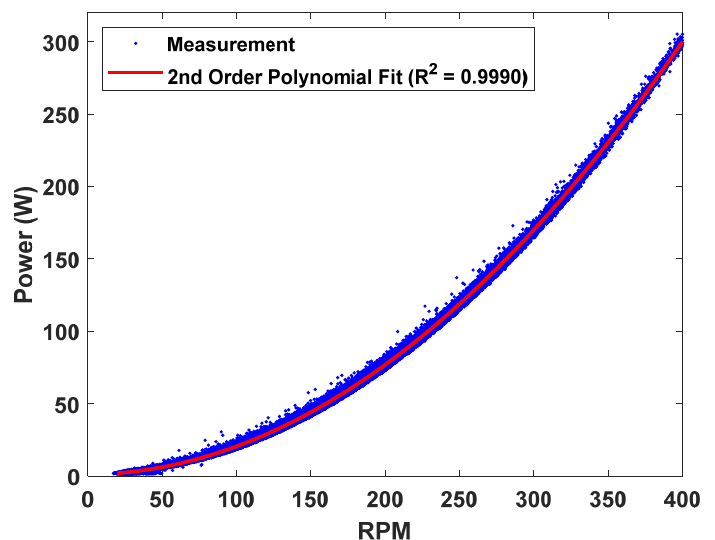
Figure 6. Rotor speed in RPM and the power output. The dotted points and solid line indicate the measured values and the second-order polynomial fitted line, respectively.